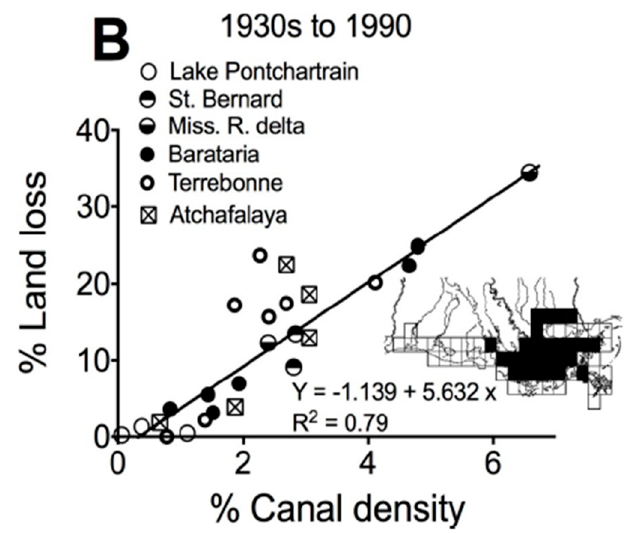
Figure 11. The land loss rate from the 1930s to 1990 and canal density in 15-min quadrangle maps. The authors of [18] concluded that this demonstrates that most wetlands loss is due to canals. This is incorrect, however, because of the large size of 15-min quadrangle maps and other causes of land loss due to induced subsidence and toxic stress.